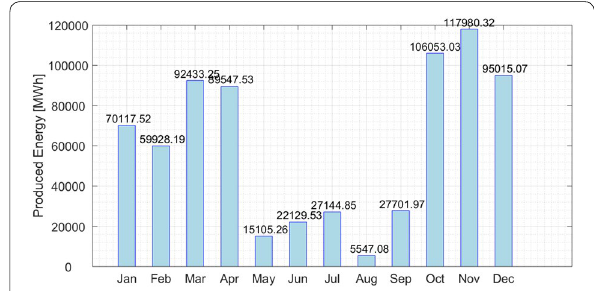
Fig. 20 Annual wind energy production on Corvo island